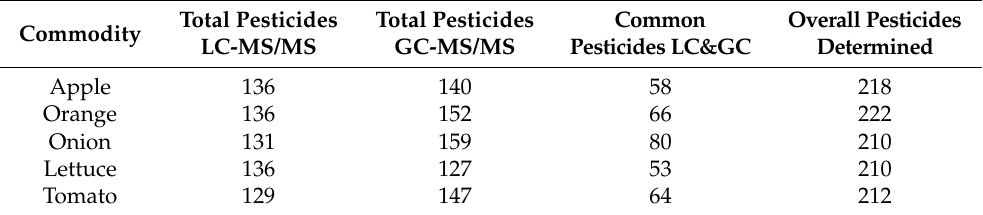
Table 6. Number of pesticides that satisfied the developed method’s validation criteria, in each commodity tested using the two chromatography